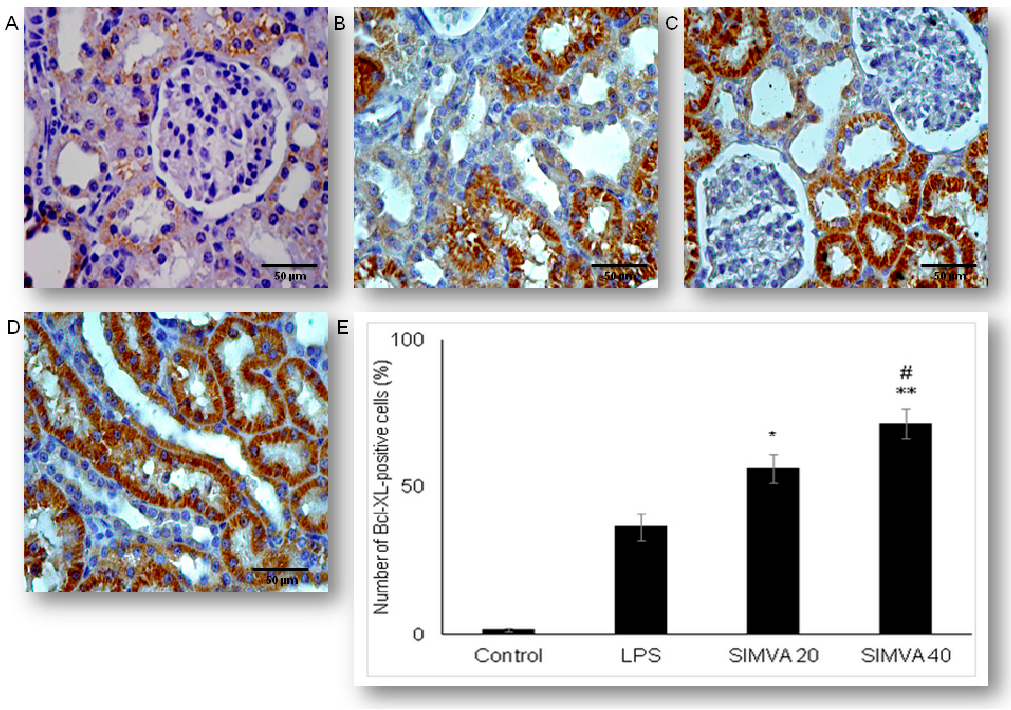
Figure 5. Simvastatin increased Bcl-XL expression in renal tubular epithelial cells after LPS administration. The expression of Bcl-XL in renal tissue was examined by immunohistochemical staining, magnification 400x, ( A ) the control group showed rare immuno-positive cells, ( B ) note Bcl-XL-expression in the tubular epithelial cells in the LPS group, in simvastatin 20 mg/kg ( C ) and 40 mg/kg group ( D ), respectively. Bcl-XL expression significantly increased, and it is determined as intensive brown cytoplasmic staining widely distributed in renal tubular epithelial cells. ( E ) A quantitative analysis of Bcl-XL-positive renal tubular epithelial in renal tissue (* p < 0.05 vs. LPS group, ∗∗ p < 0.05 vs. simvastatin 20 group, # p < 0.01 vs. LPS